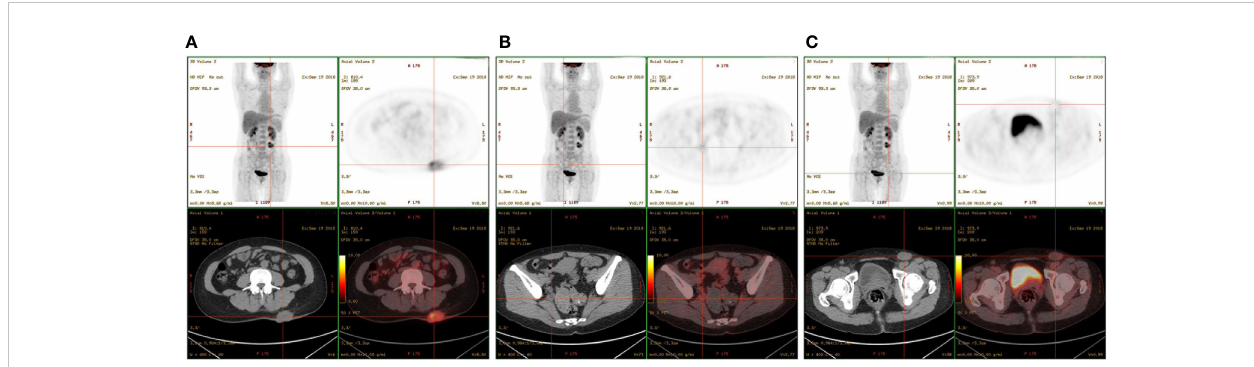
FIGURE 1 PET-CT showed multiple masses located in the (A) left lower back, (B) right pelvic wall, and (C) inguinal